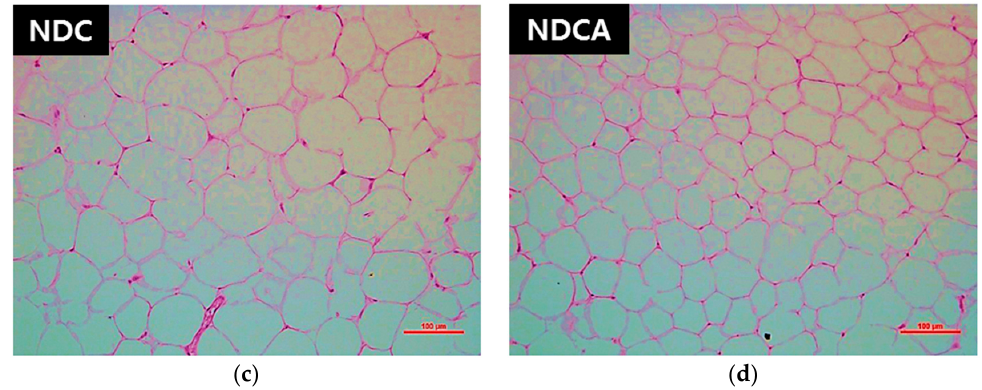
Figure 7. Effect of supplementation of non-dairy creamer-enriched high-fat diet with D-allulose on hepatic and adipose tissue morphology in C57BL/6J mice fed the diet for 8 weeks: ( a ) hematoxylin and eosin-stained transverse section of the liver in the NDC group; ( b ) hematoxylin and eosin-stained transverse section of the liver in the NDCA group; ( c ) hematoxylin and eosin-stained transverse section of epididymal fat tissue in the NDC group; ( d ) hematoxylin and eosin-stained transverse section of epididymal fat tissue in the NDCA group. NDCA, high-fat with non-dairy creamer + 5% D-allulose; NDC, high-fat diet with non-dairy creamer. Representative photomicrographs of the liver and epididymal fat are shown at ×200 magnification. 3.5. Plasma Adipokines and Cytokines leptin-to-adiponectin ratio compared with the NDC diet (Figure 8a,b,d), although plasma adiponectin was not affected (Figure 8c). IL-10, an anti-inflammatory factor in the plasma, was